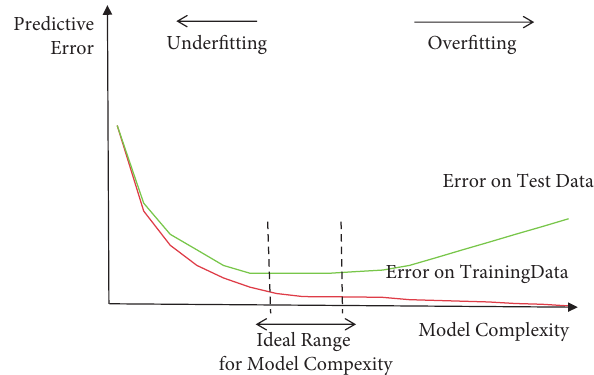
Figure 3: Structure of MLM complexity for over- and